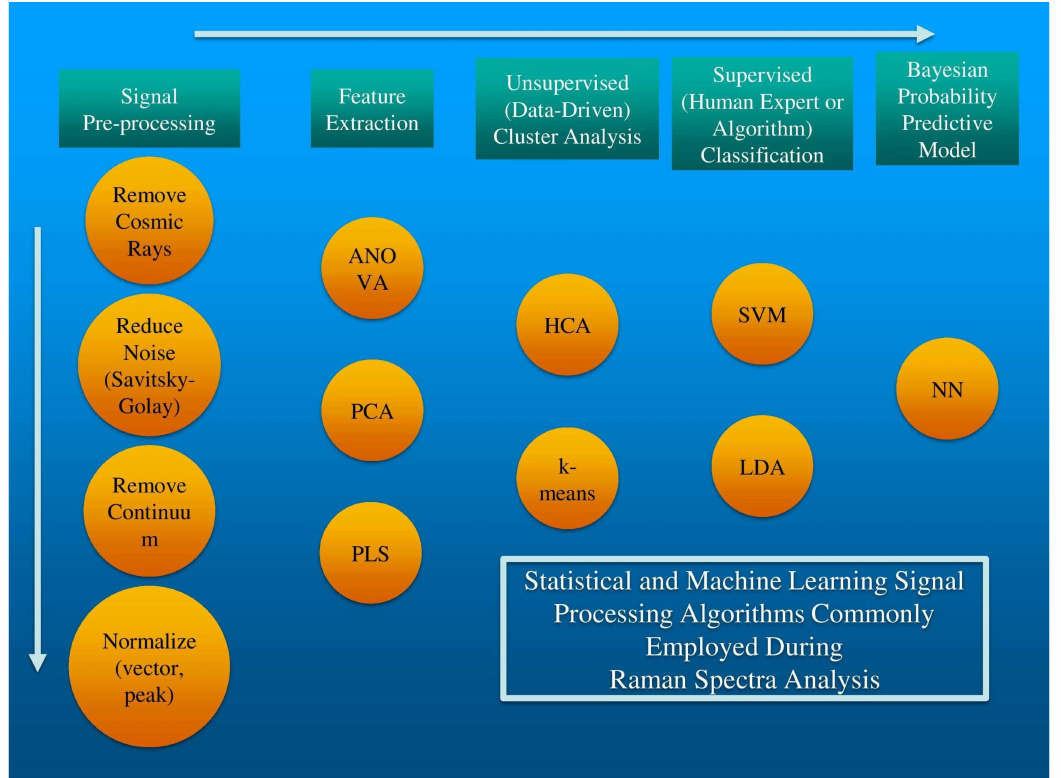
Figure 2. The data processing steps required for robust Raman spectral analysis with the various algorithms that can be used for each